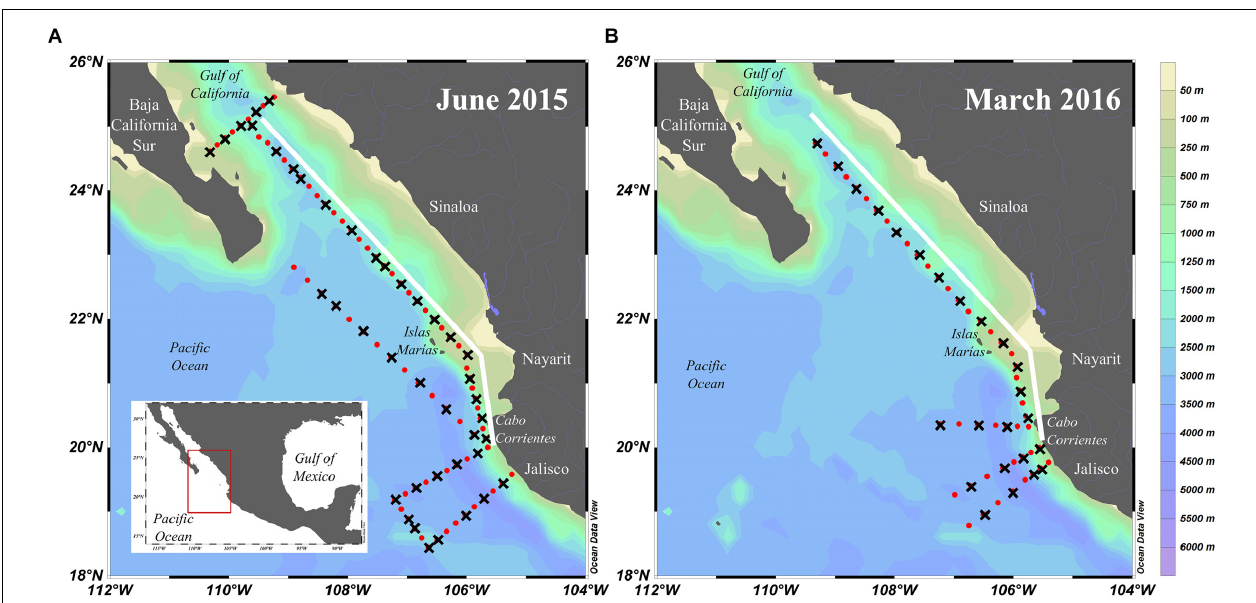
FIGURE 1 | Hydrographic transects in the studied region over the bathymetric map. (A) June 3–16, 2015, (B) March 2–8, 2016. Black crosses depict stations with water sampling for chemical analysis, while red dots indicate only hydrographic stations. Latitudinal transect 1 appears as a white line.